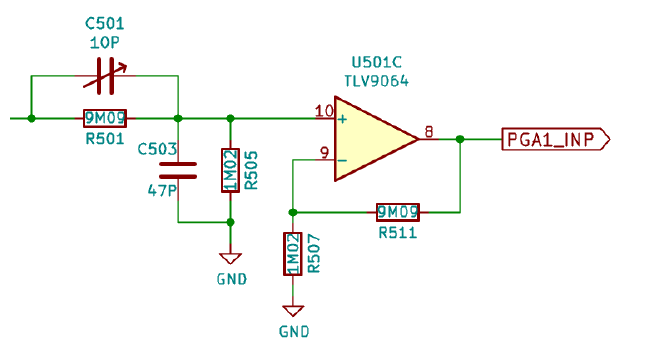
Figure 3. Schematic of a DSO voltage input channel.